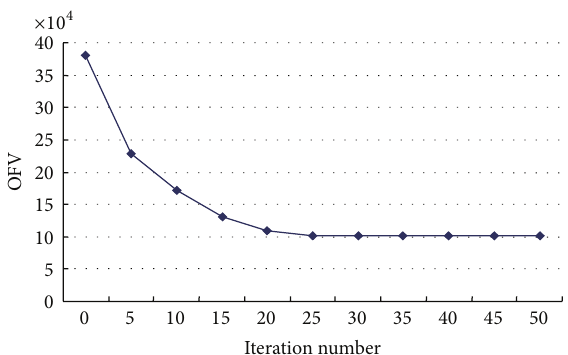
Figure 6: Objective value of lower model versus iteration number of